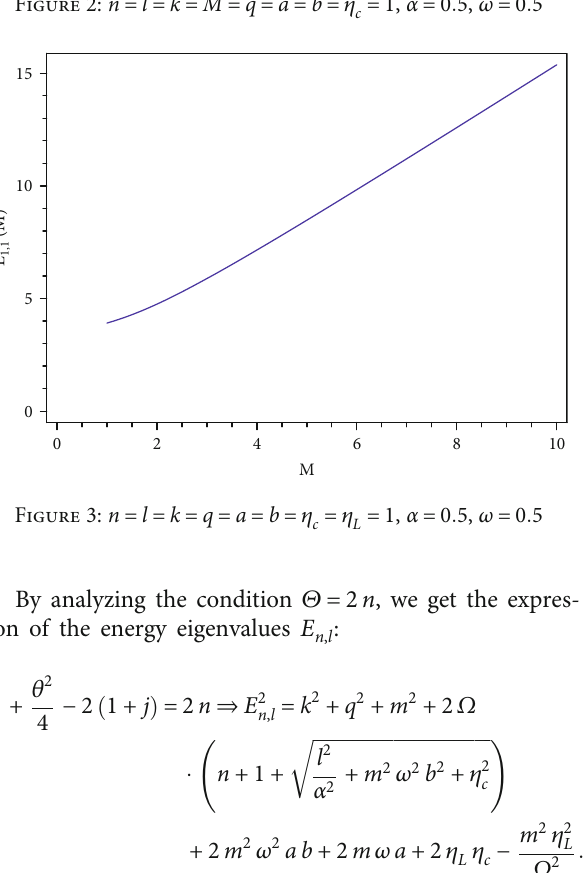
= 1 , α = 0 : 5 , ω = 0 : 5 : Figure 2: n = l = k = M = q = a = b = η L